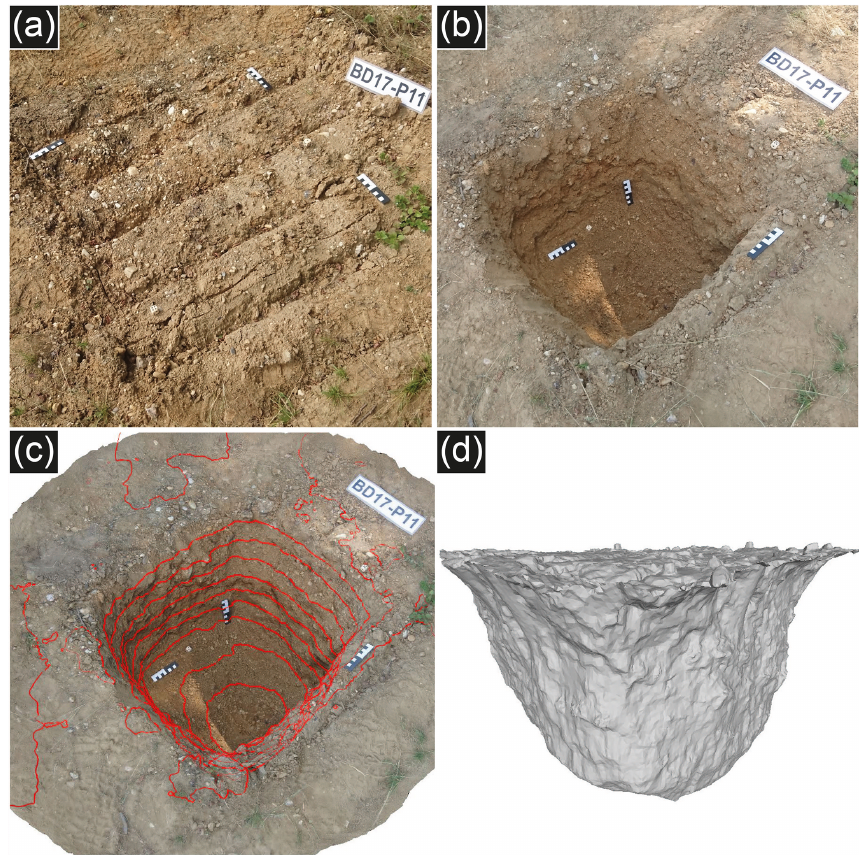
Figure 4. Test site BD17-P11. The pit was dug into gravel situated in a sandy–silty matrix (a, b) . The reconstructed pit is shown with 5cm contours in red (c) . The large grain sizes dominating the substrate into which the pit was dug are reflected by the high surface roughness of the final watertight mesh (d)